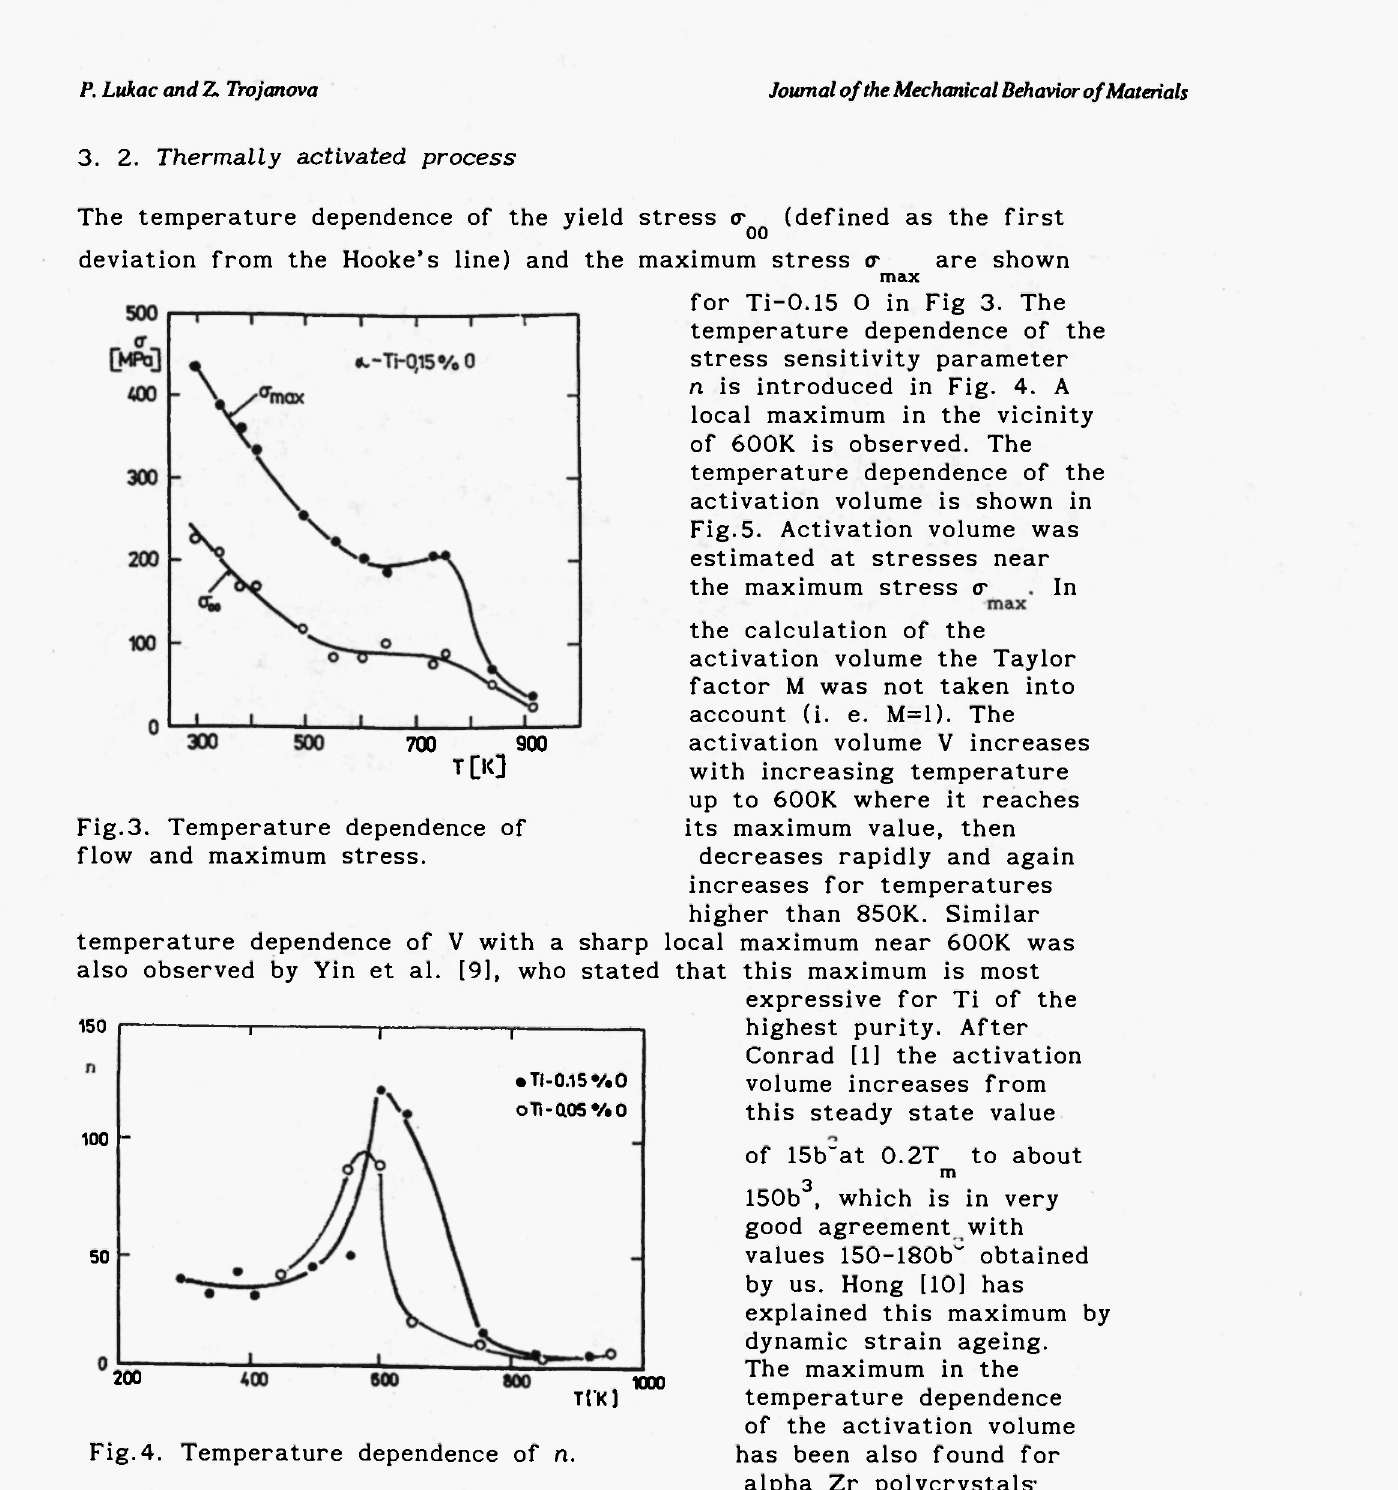
Fig.3. Temperature dependence of flow and maximum